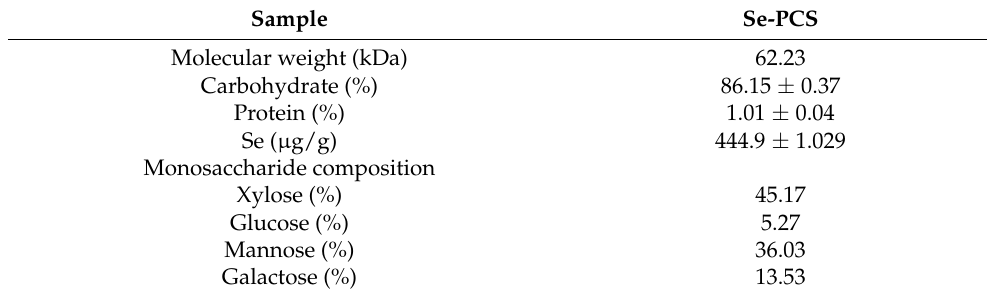
Table 1. Chemical composition, molecular weight, and monosaccharide composition of